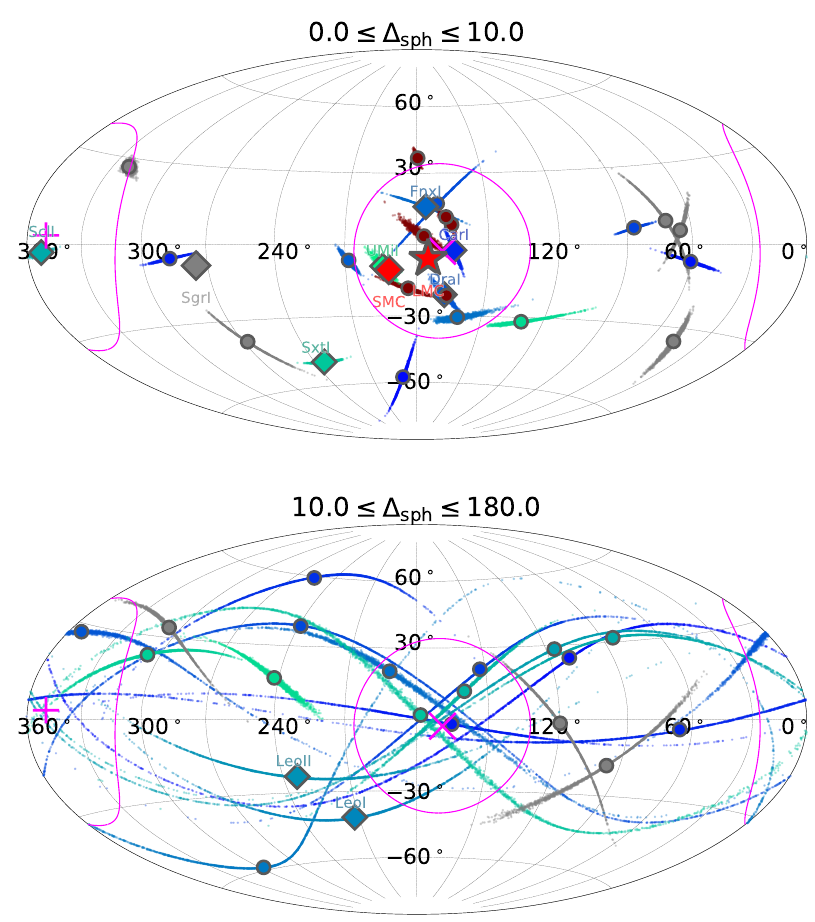
Figure 3. Most likely orbital poles (directions of angular momenta, large symbols) and their un- certainties (colored bands) for the MW satellite galaxies, based on their Gaia eDR3 proper motions from [49]. We also include the orbital poles for the LMC, SMC, and Sagittarius from [58]. The classical satellites are shown as diamonds and labeled, while the fainter satellites are shown as dots. The uncertainties in orbital pole directions are obtained by Monte Carlo sampling of the proper motion and distance uncertainties. The upper panel shows the well-constrained orbital poles (1 σ uncertainty in direction ∆ sph < 10 ◦ ), while the lower panel shows those with only weakly constrained or uncon- strained orbital poles ( ∆ sph > 10 ◦ ). Satellites whose position alone already places them outside of the VPOS are plotted in grey: their orbital poles have no opportunity to align with the VPOS normal vector. Likely satellites of the LMC are plotted in dark red [59]. The pink cross and circle indicate the direction of the normal vector of the VPOS and the 10% area around it. Among the satellites with well-constrained orbital poles ( upper panel ), there is a pronounced preference to cluster in this direction, indicating that satellites preferentially co-orbit along this plane. This is not only driven by the likely LMC satellites but also by other MW satellites, including more massive classical satellites at large distances from the LMC. Among the satellites with only weakly constrained orbital poles ( lower panel ), many are consistent with orbiting along the VPOS within their